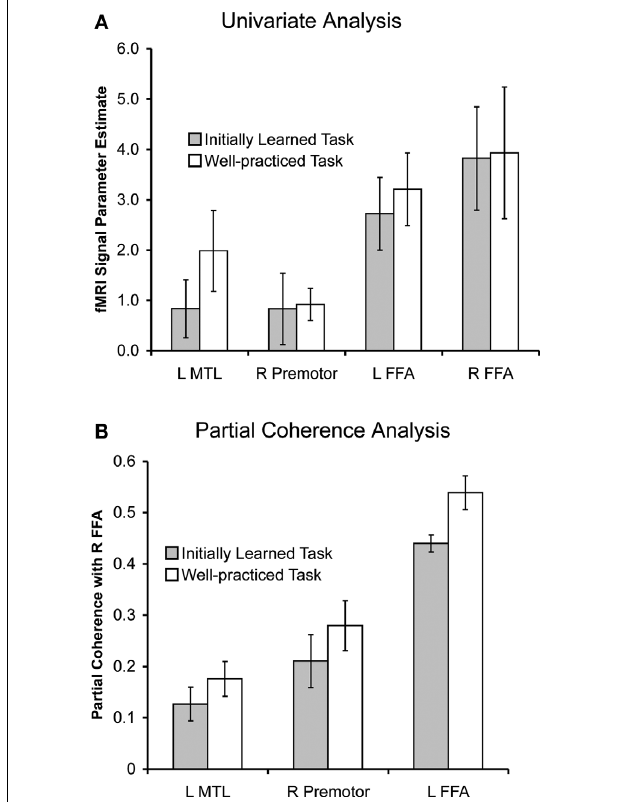
FIGURE 6 | Univariate parameter estimates (A) and right FFA partial coherence values (B) for regions that showed signifi cant differences between in the initially learned and well-practiced tasks, indicated by